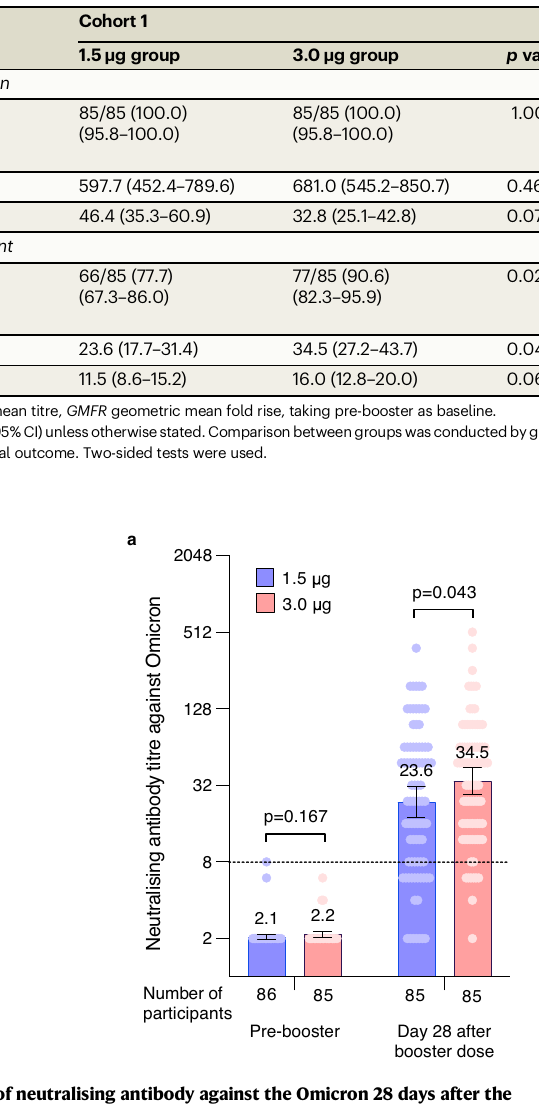
Table 2 | Immunogenicity assessment on day 28 after the third